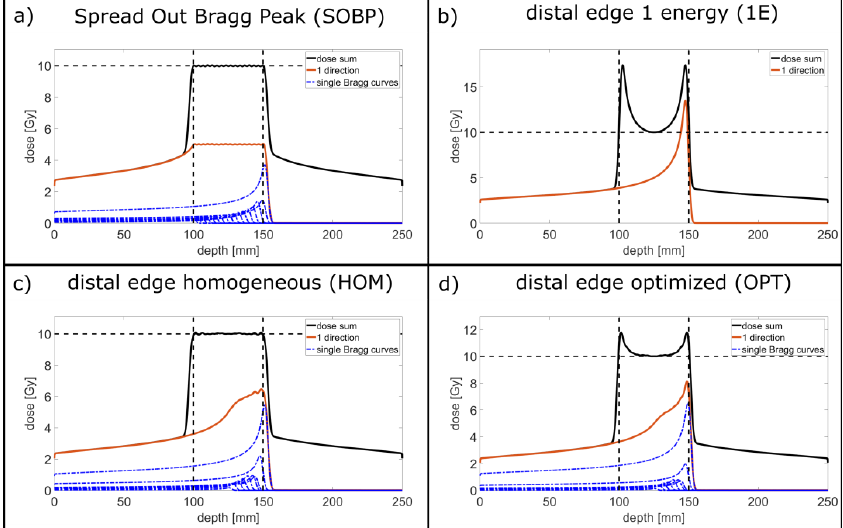
Figure 1. Depth-dose curves for the four considered longitudinal irradiation modes. ( a ) Spread Out Bragg Peak (SOBP). ( b ) distal edge 1 energy (1E). ( c ) distal edge homogeneous (HOM). ( d ) distal edge optimized (OPT) . The blue dashed–dotted lines mark the single Bragg curves being the depth- dose distributions from one-sided irradiations of one proton energy that are optimized in height to achieve the summed depth-dose curves plotted as black lines. The red curves describe the sum of all single Bragg curves from one direction. The dashed lines mark the tumor edges (vertical) and the prescribed dose of 10 Gy (horizontal).